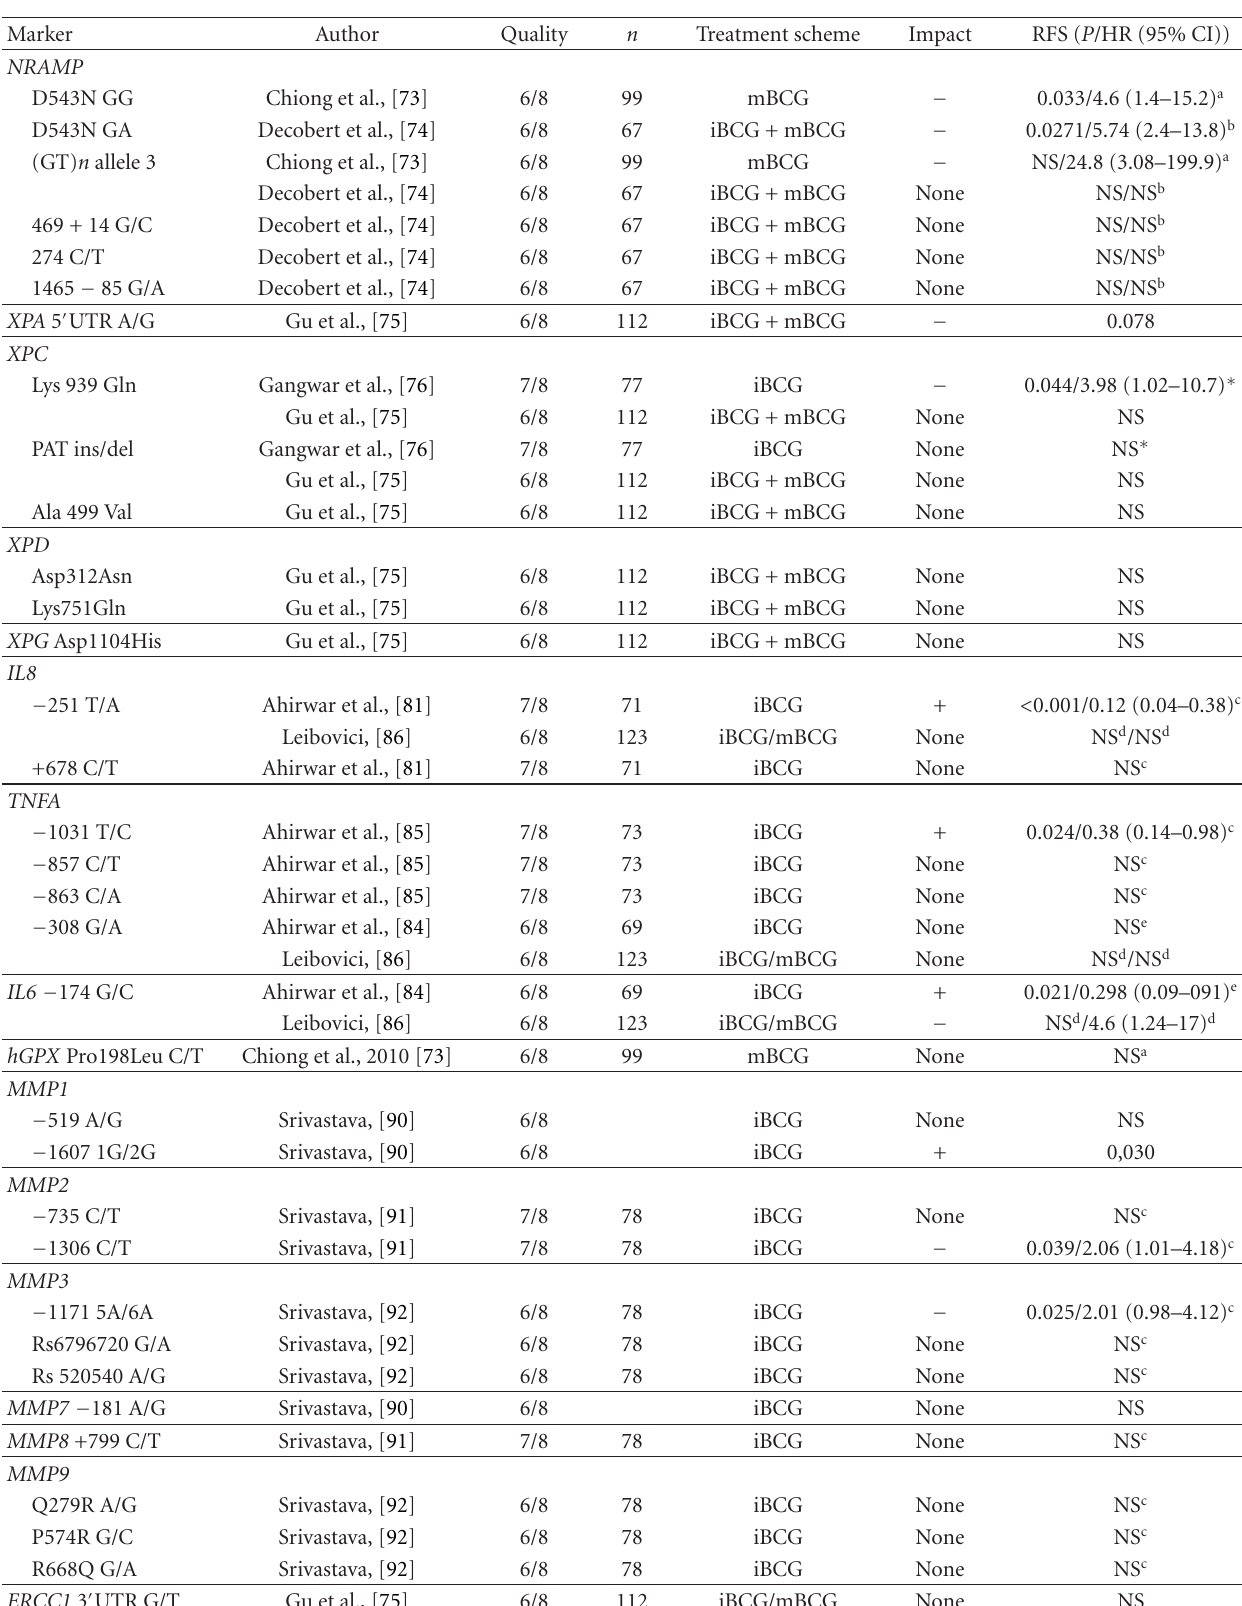
Table 3: Genetic polymorphisms associated to BCG outcome. The markers are ordered from the most studied to the less, and, within each marker, the studies are ordered by quality